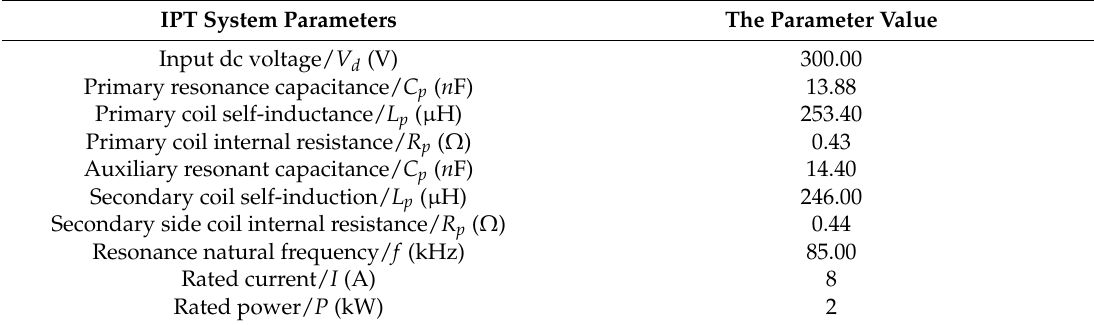
Table 1. Values of system.